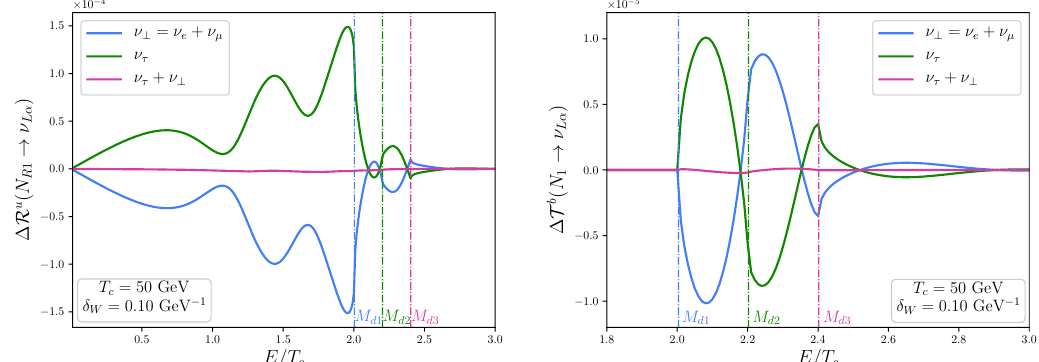
Figure 4 . CP asymmetries in the re(cid:13)ection and transmission of N R 1 (left panel) and N 1 (right panel), respectively, into the (cid:28) -(cid:13)avour neutrino or the combination of e + (cid:22) (cid:13)avours. In magenta we have the sum of the two asymmetries, which tend to cancel each other. Here we have used the FLOR pro(cid:12)le de(cid:12)ned in eq. (3.12). M 1 , M 2 and M 3 are set to 100, 110 and 120 GeV respectively